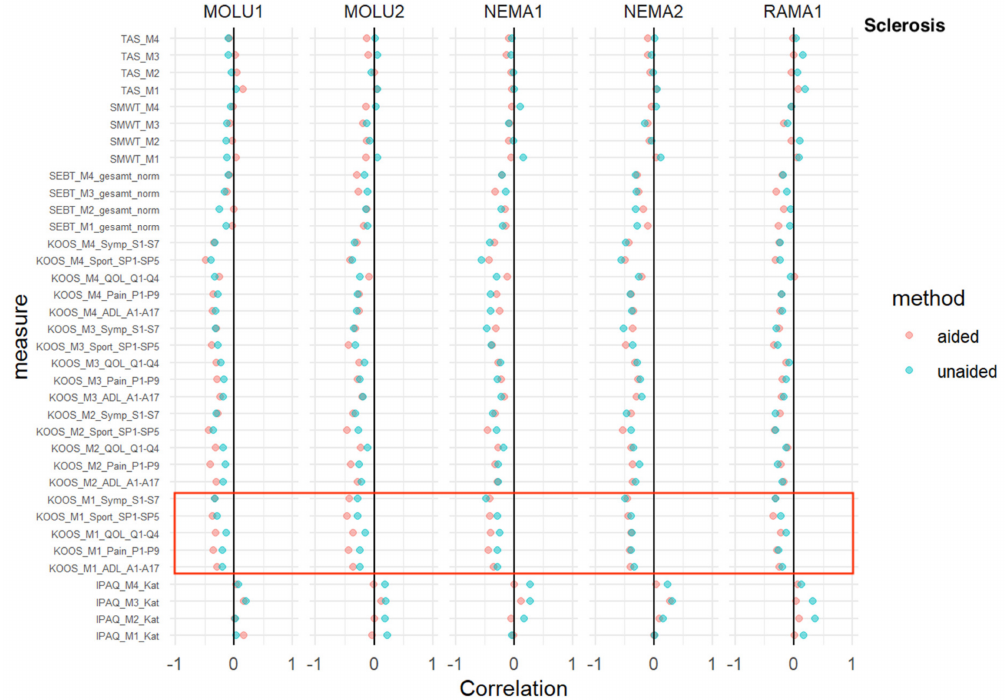
Figure 5. Sclerosis —correlation analysis for AI-aided (red dots) versus AI-unaided (green dots) readings with clinical scores. Red square marks all baseline KOOS scores